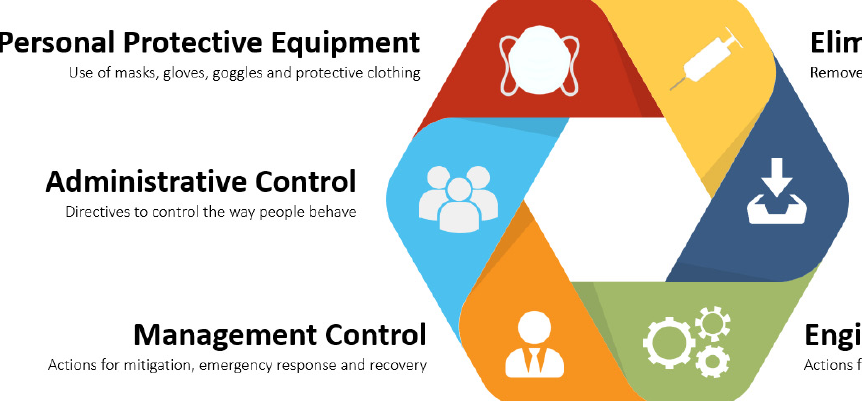
Figure 3. Multi-pronged strategy of controls [44].